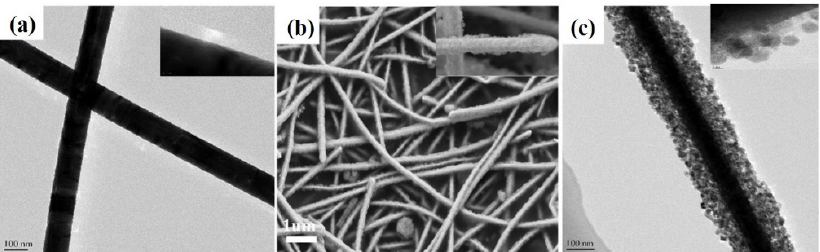
Figure 1. TEM images of Ag nanowires ( a ) (insert: high magnification); SEM of AWT after 450 °C calcinated ( b ) (insert: SEM image); TEM of AWT after 450 °C calcinated ( c ) (insert: HRTEM image).